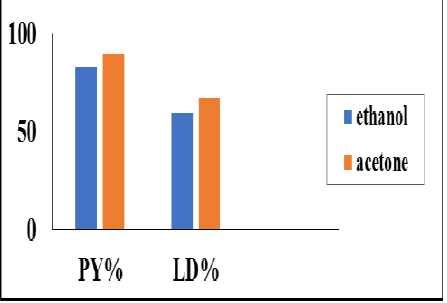
Figure (3) Effect of solvent type on physical properties of microsponges